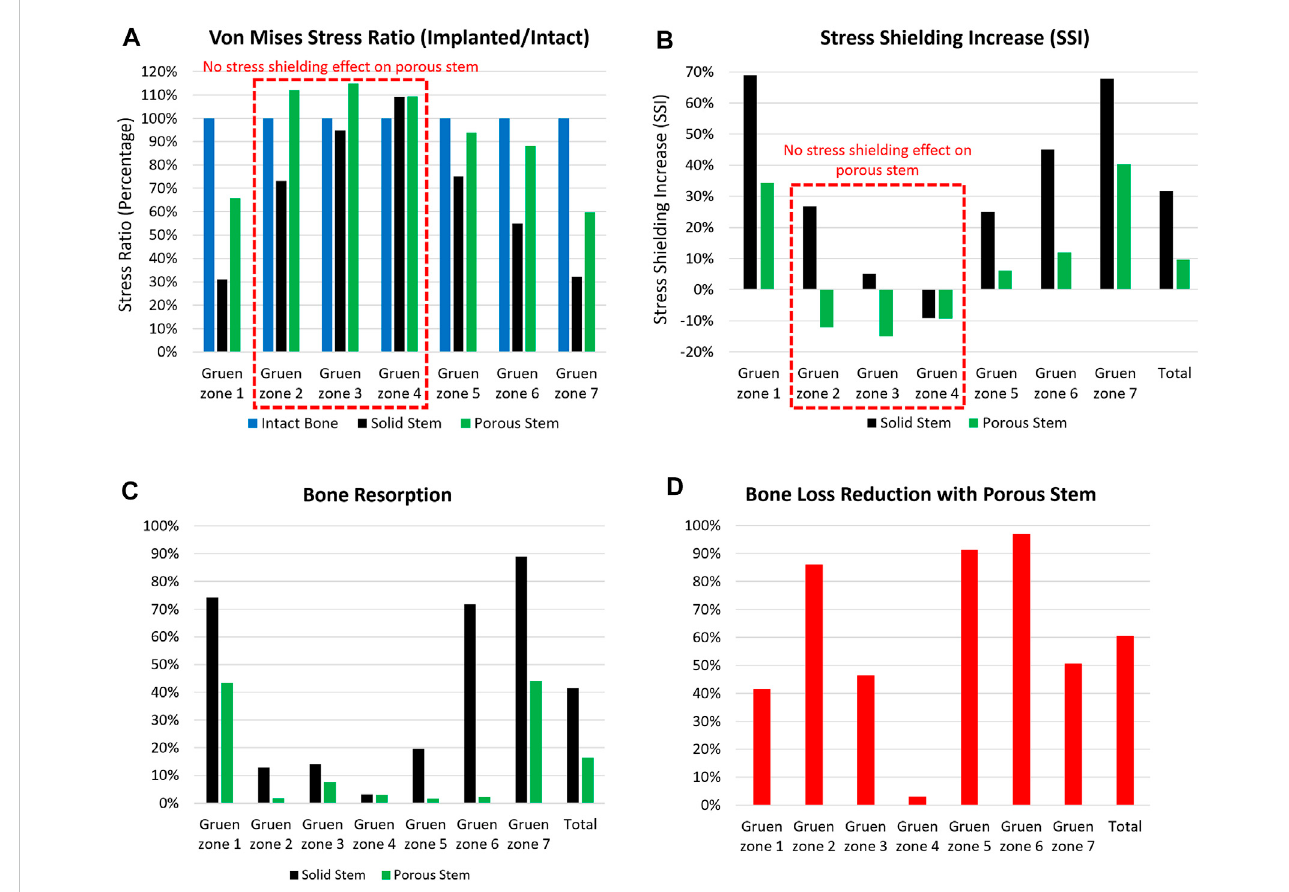
FIGURE 8 The (A) vonMisesstressratio, (B) stressshieldingincrease, (C) boneresorption,and (D) bonelossreductionwithporousstemvs.solidstemineachGruen zone (1 – 7). Total value shows the overall performance of the stem in all Gruen zone combined